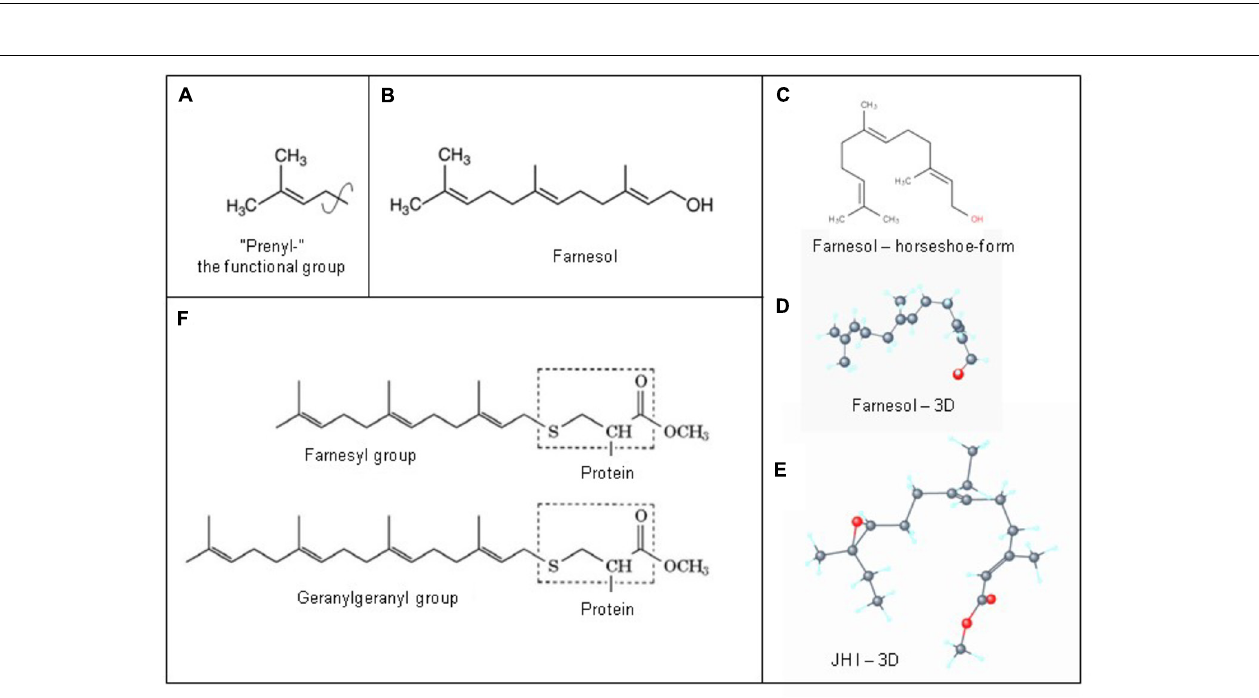
FIGURE 7 | Prenylation. (A) The chemical structure of a “prenyl”-group and of farnesol. (B) In textbooks farnesol is usually depicted in its linear 2D configuration. (C) Its 3D conformation is horseshoe-shaped. (D,E) : the 3D configuration showing all atoms of all-trans-farnesol and of Juvenile Hormone I (JH I) (according to PubChem). (F) Protein prenylation is the covalent addition of a farnesyl- or geranyl-geranyl moiety to the C terminus of specific proteins, e.g., α or γ G protein. Adapted from Wikipedia: Prenylation, from Wikipedia: Farnesol and from PubChem: Farnesol and Juvenile Hormone I. With thanks. Copyright permission not